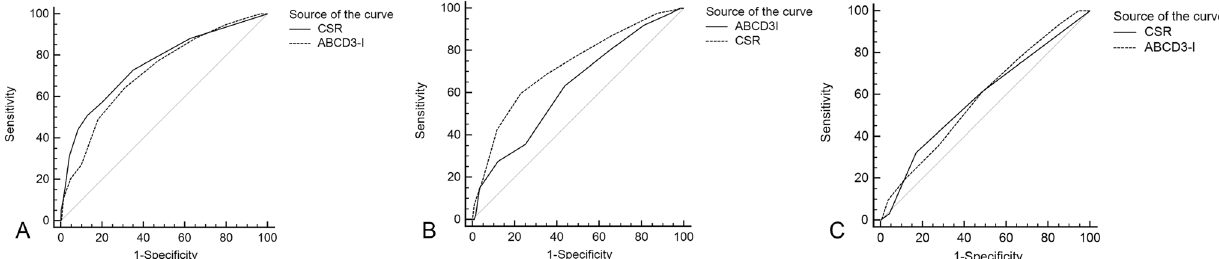
Figure 3. Ninety-day receiver-operating characteristic curves as a predictive value of the CSR score and ABCD 3 -I score. ( A ) The C statistic of CSR model (0.754; 95% CI 0.729–0.778) was similar with that of ABCD 3 -I score (0.717; 95% CI 0.691–0.743, Z = 1.400; P = 0.1616) in TIA patients; ( B ) CSR score showed better discrimination (Z = 2.294, P = 0.0245) with the C statistic of 0.725 (95% CI 0.683–0.765) than ABCD 3 -I score (0.626; 95% CI 0.581–0.670) in DWI-positive subjects. ( C ) The C statistic of CSR model (0.585; 0.548–0.622) was similar with that of ABCD 3 -I score (0.588; 0.551–0.624, Z = 0.0362; P = 0.9711) in TIA patients with negative